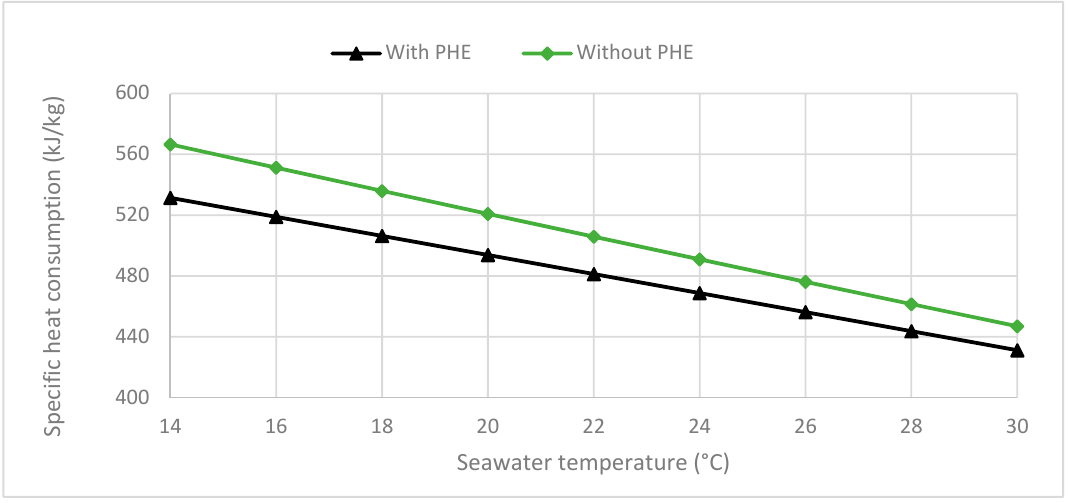
Figure 4. Specific heat consumption for both systems versus seawater temperature.